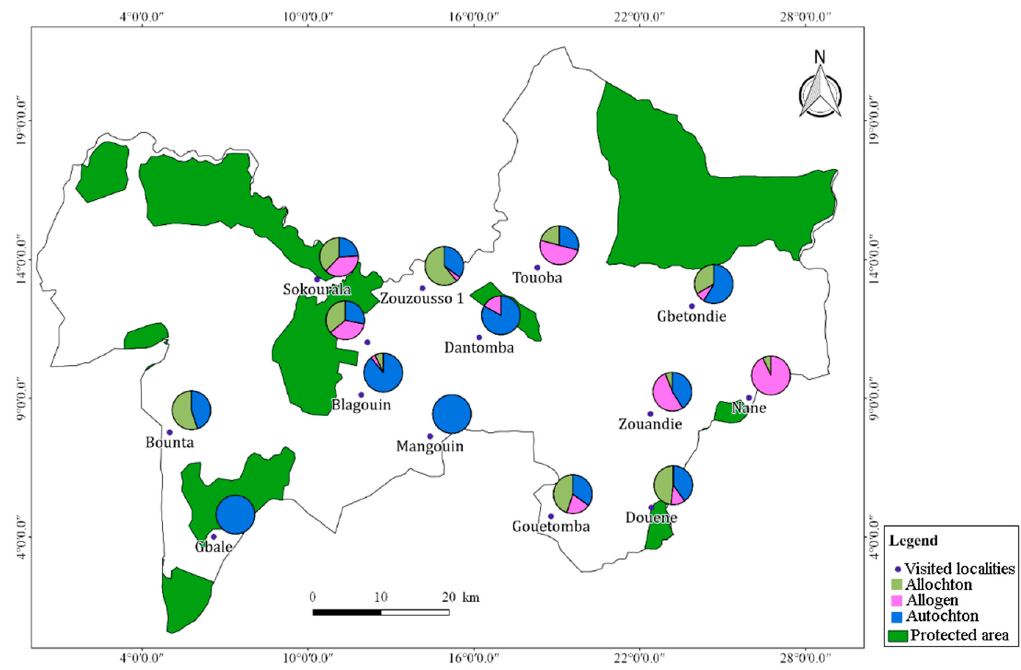
Figure 9. Origin of cocoa farmers in Biankouma region.